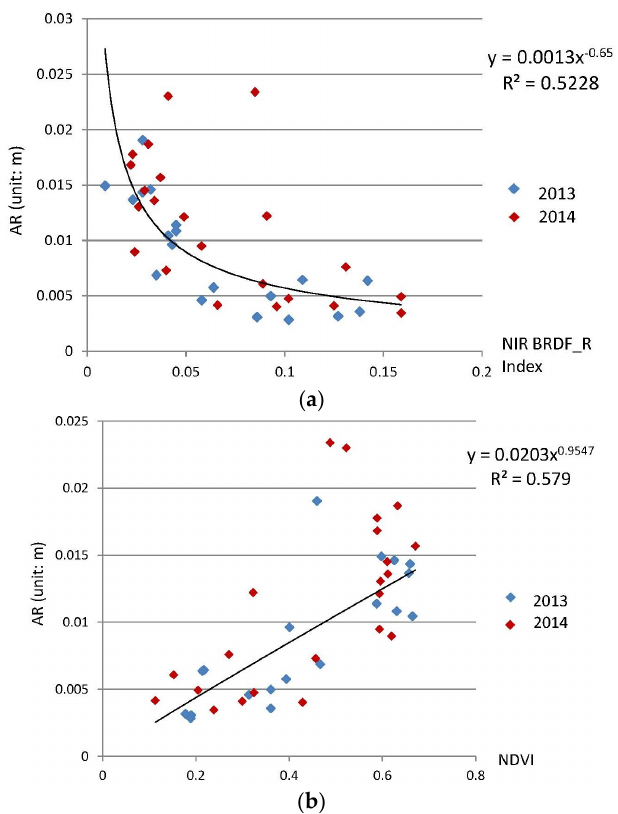
Figure 4. Relationship between the MODIS NIR BRDF_R index and the field AR ( a ) and between the MODIS NDVI and the field AR ( b ).